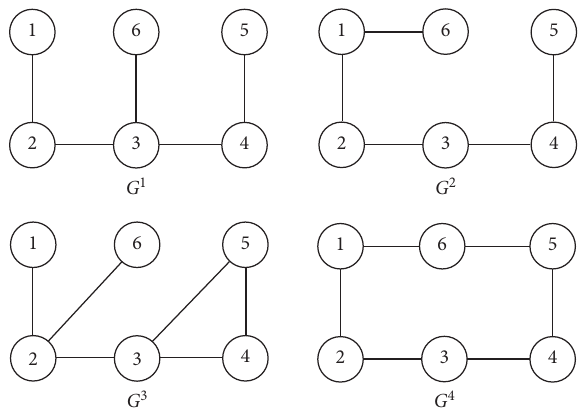
Figure 1: Leaderless switching topologies.